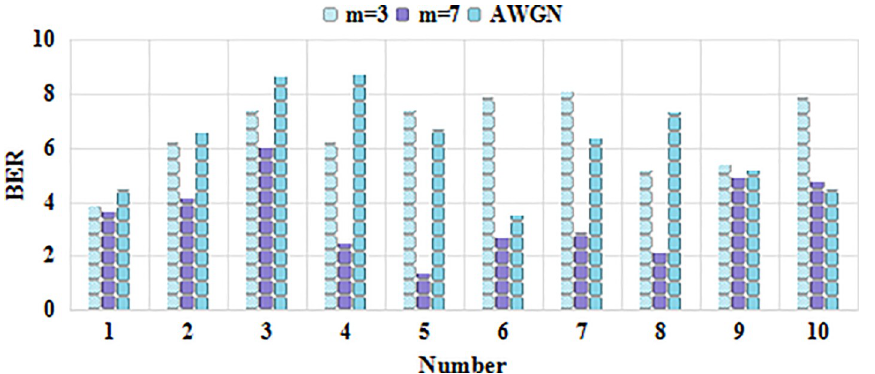
Fig 4. Higher rating.